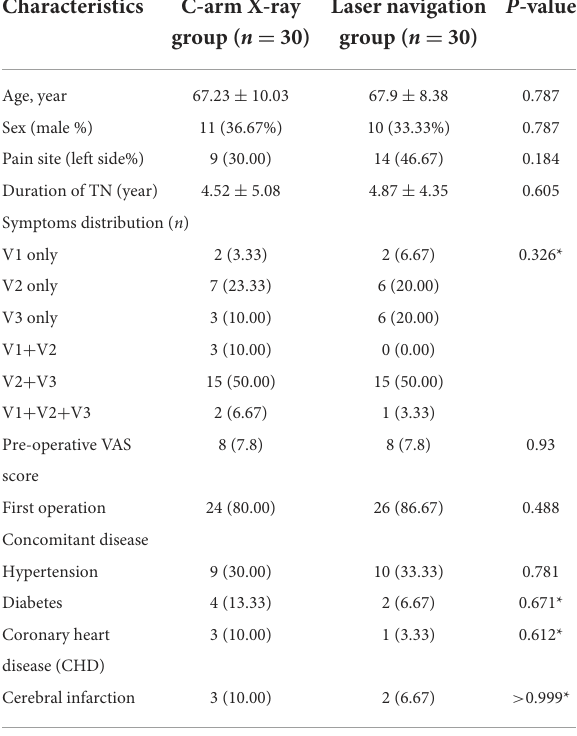
TABLE 1 Characteristics of patients in C-arm X-ray group and laser navigation group.